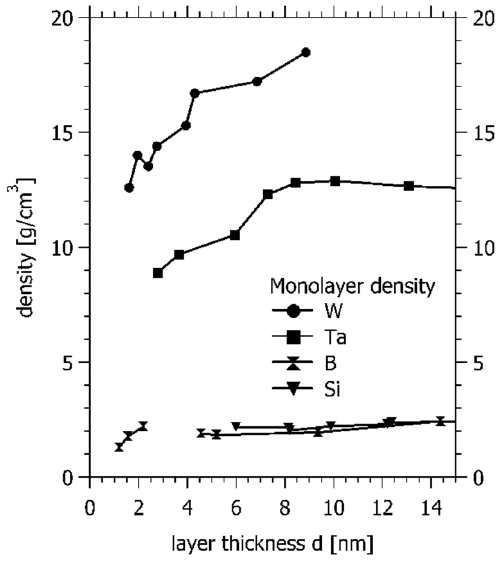
Figure 5. Density vs. monolayer thickness for series of deposited materials.